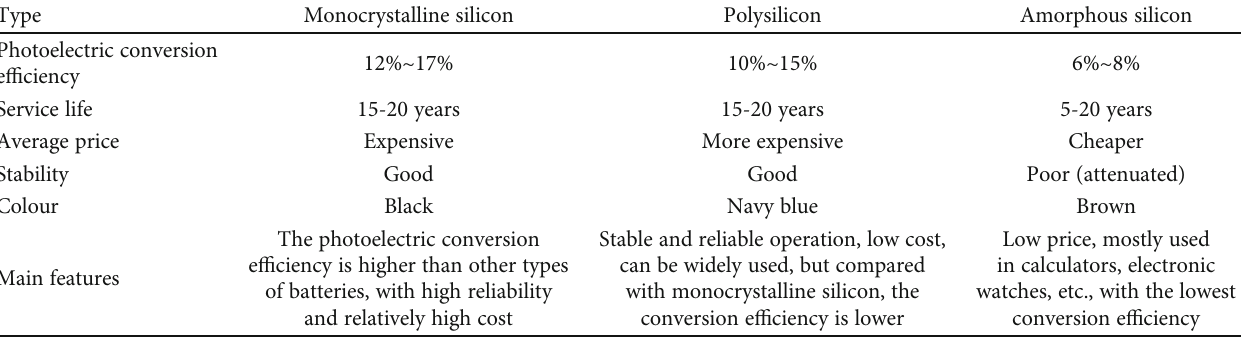
Table 1: Types and characteristics of common photovoltaic cells.